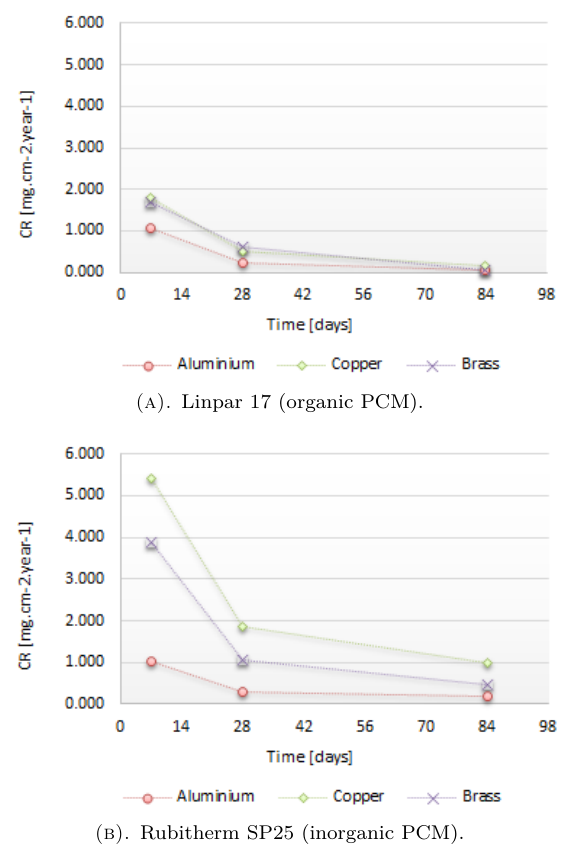
Figure 1. Comparison of the dependence of CR value (in mg cm − 2 year − 1 ) of metals in two types of PCMs.